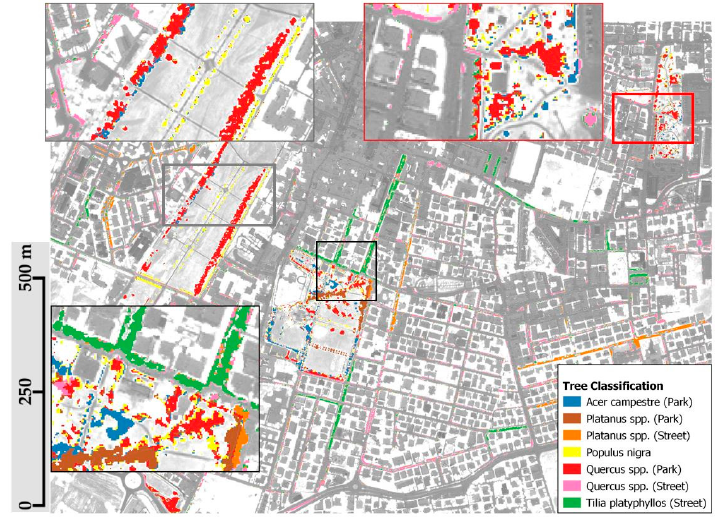
Figure 8. The overall classification obtained with the OBIA approach utilizing WV3 data for the study area in Sassuolo.